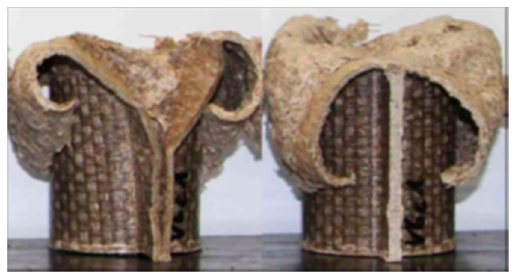
Figure 15. Rear and front part of V6_c specimen after crash test.